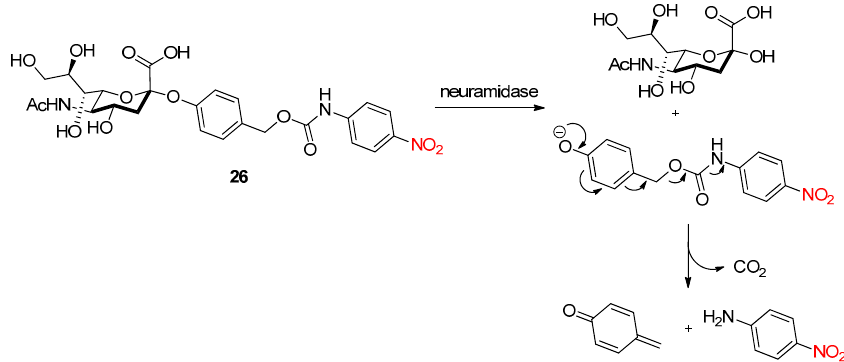
Scheme 29. A plausible mechanism of neuraminidase-triggered activation of 26